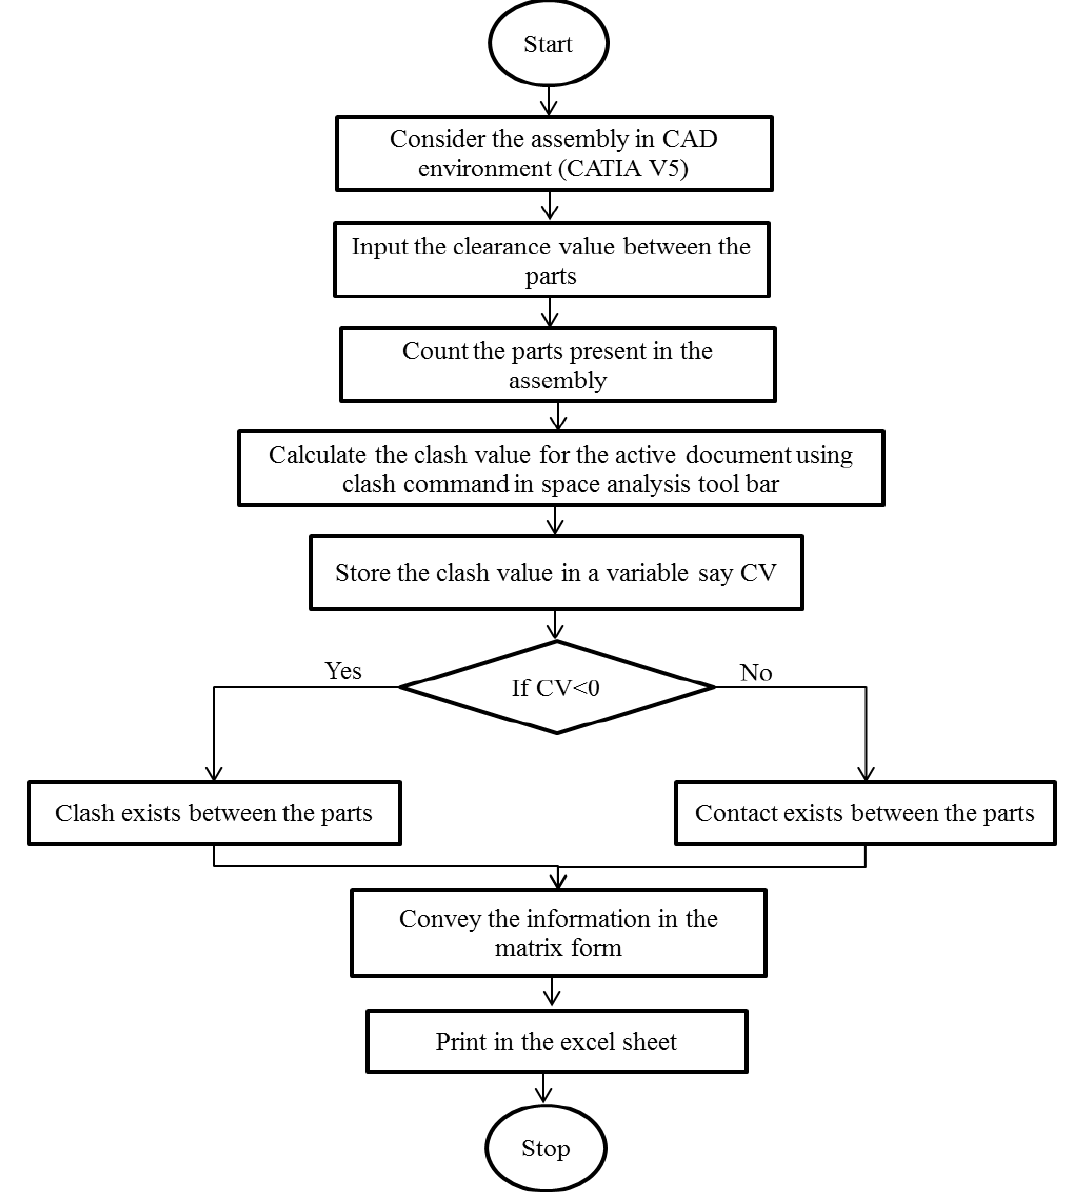
Figure 1. Represents the detailed flowchart of automatic clash analysis Algorithm